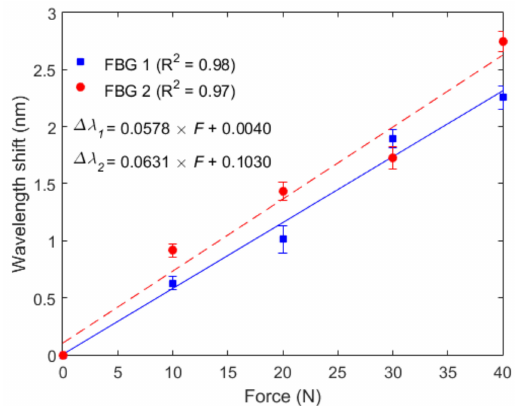
Figure 5. Force characterization of FBG 1 (embedded in the shank flexible support 1) and FBG 2 (embedded in the shank flexible support 2) at constant temperature of 25 ◦ C.